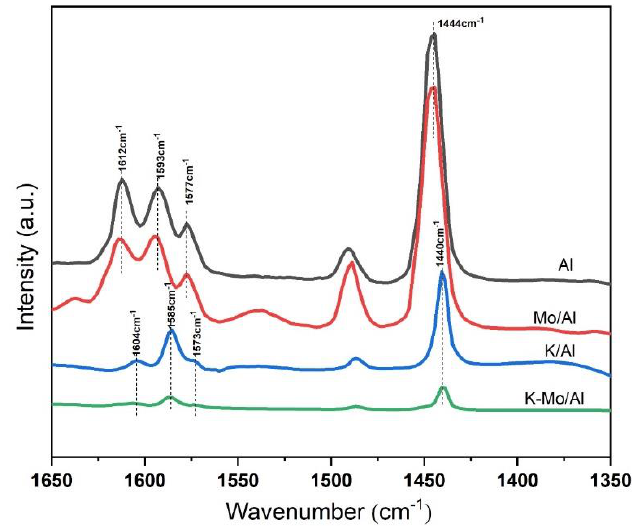
Figure 7. Spectra of pyridine adsorbed on the catalysts at 50 °C.